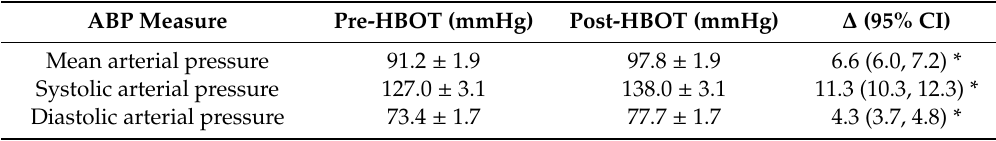
Table 2. Temporal dynamics in arterial blood pressure measurements before and after each HBOT sessions.